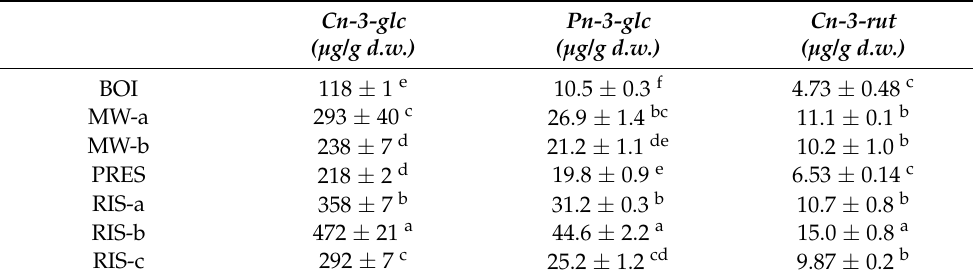
Table 4. Anthocyanins ( µ g/g d.w.) identified in cooked black rice; the results are expressed as mean ± standard deviation. Values with different letters in the same column are significantly different ( p < 0.05).